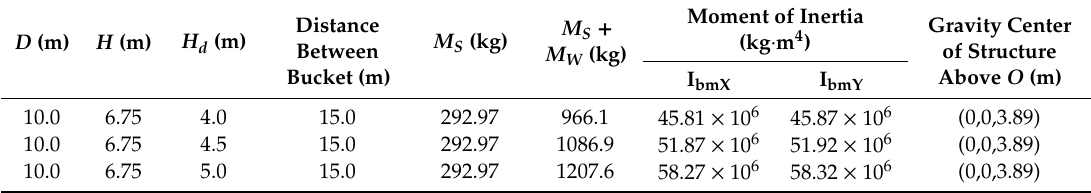
Table 2. Pertinent parameters for the numerical simulations of the prototype in MOSES.